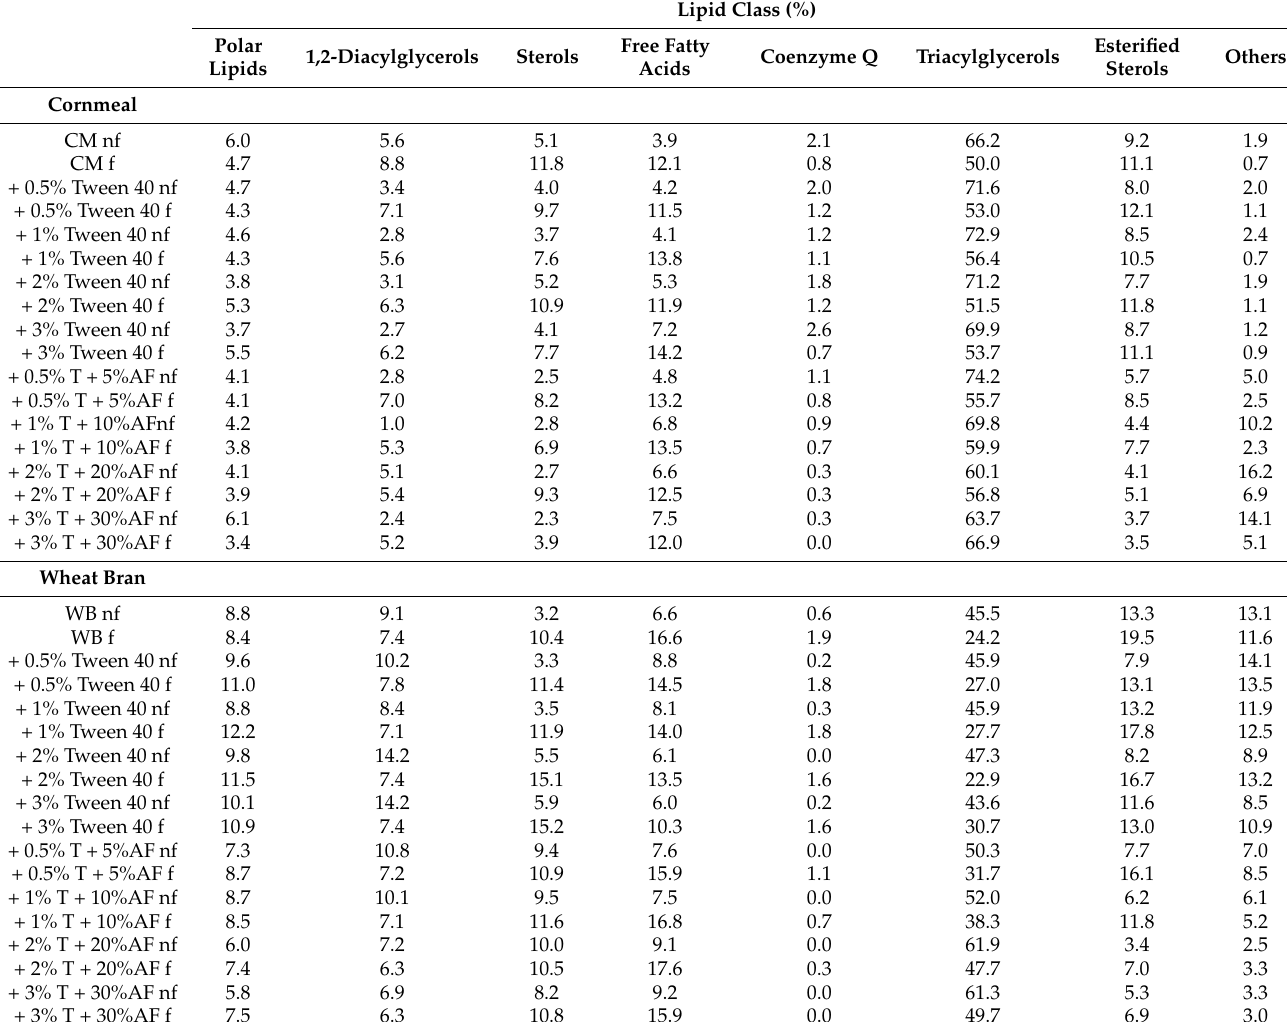
Table 5. TLC results describing the percentual representation of individual lipid classes in non-fermented substrate mixtures (nf) and fermented bioproducts (f) prepared by SSF of Umbelopsis isabellina CCF2412 with the addition of different amounts of Tween ® 40 (T) and animal fat (AF). The results are an average of three independent biological replicates with α <